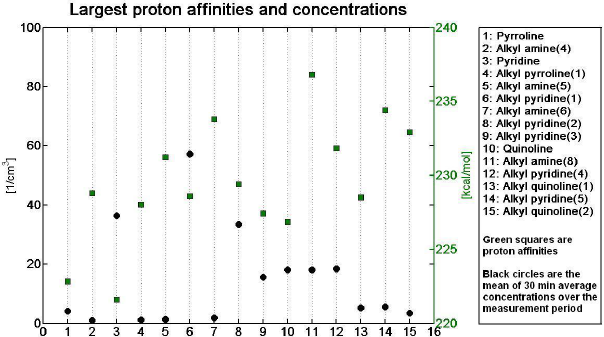
Fig. 2. Largest calculated proton affinities (green squares) for each Figure 2. Largest calculated proton affinities (green squares) for each compound and the mean 3 compound and the mean of 30min average concentrations over the of 30 min average concentrations over the measurement period (black circles, Ehn et al. 4 measurement period (black circles; Ehn et al., 2010). The value of 2010). The value of the x-axis is merely an index referring to the legend. 5 the x axis is merely an index referring to the